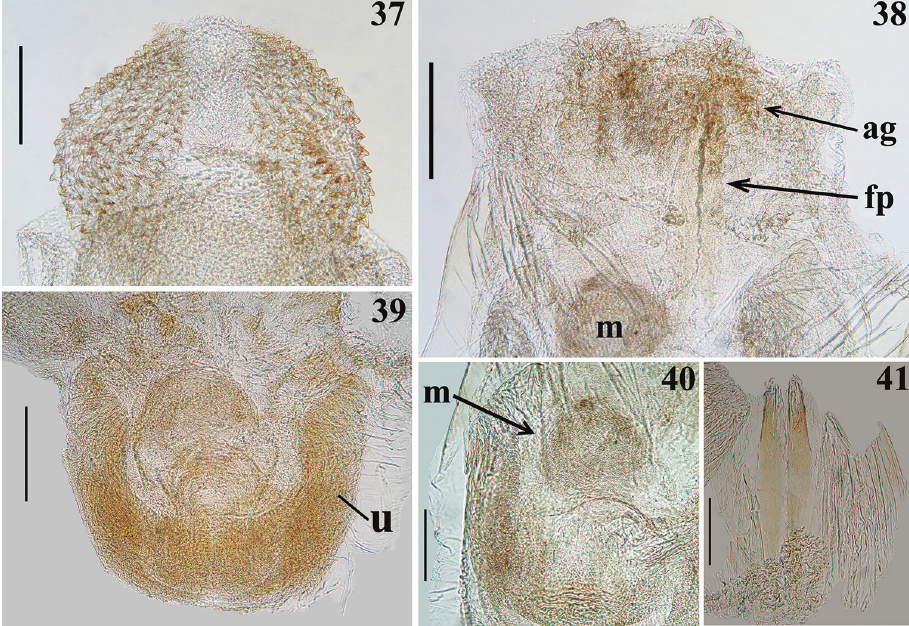
Figures 37–41. Parahiranetis salgadoi Gil-Santana, male genitalia, dorsal view. 37–40 endosoma por- tions and processes 37 globe-shaped lobe in distal third 38 distal portion 39 basal portion 40 midportion 41 a pair of elongate, flat processes. ( ag : apicolateral group of spiny processes of the endosoma; fp : pair of elongate, flat processes; m : median subspherical process; u : U-shaped basal process). Scale bars: 0.3 mm ( 37–39 ); 0.2 mm ( 40–41